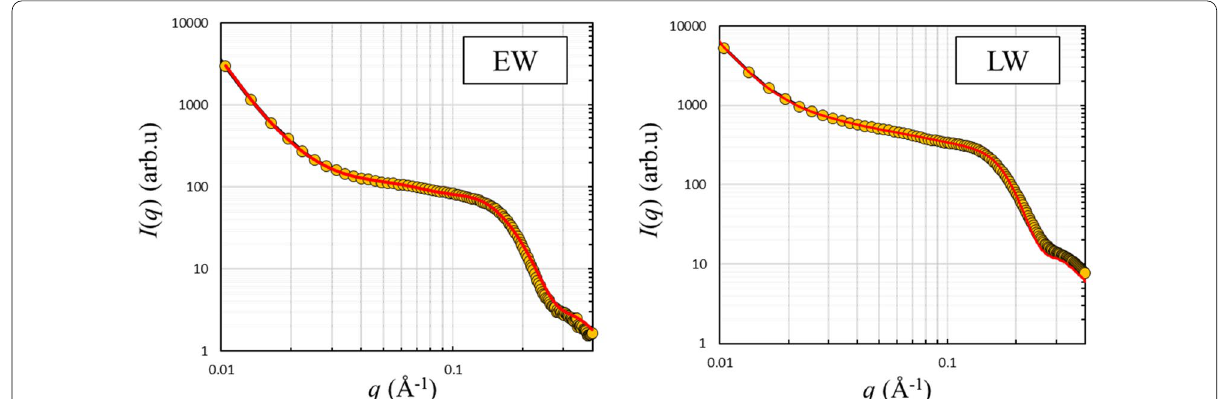
Fig. 7 Representative results of the fitting calculation with the WoodSAS model for the equatorial q - I plots for earlywood (EW) and latewood (LW) of Douglas fir swollen by water in water at 25 ℃ . The fitted curves were shown by red continuous lines